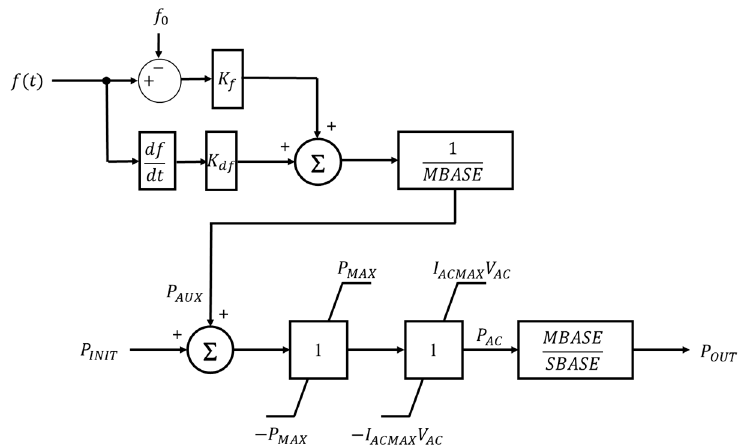
Figure 3. The active power control loop.